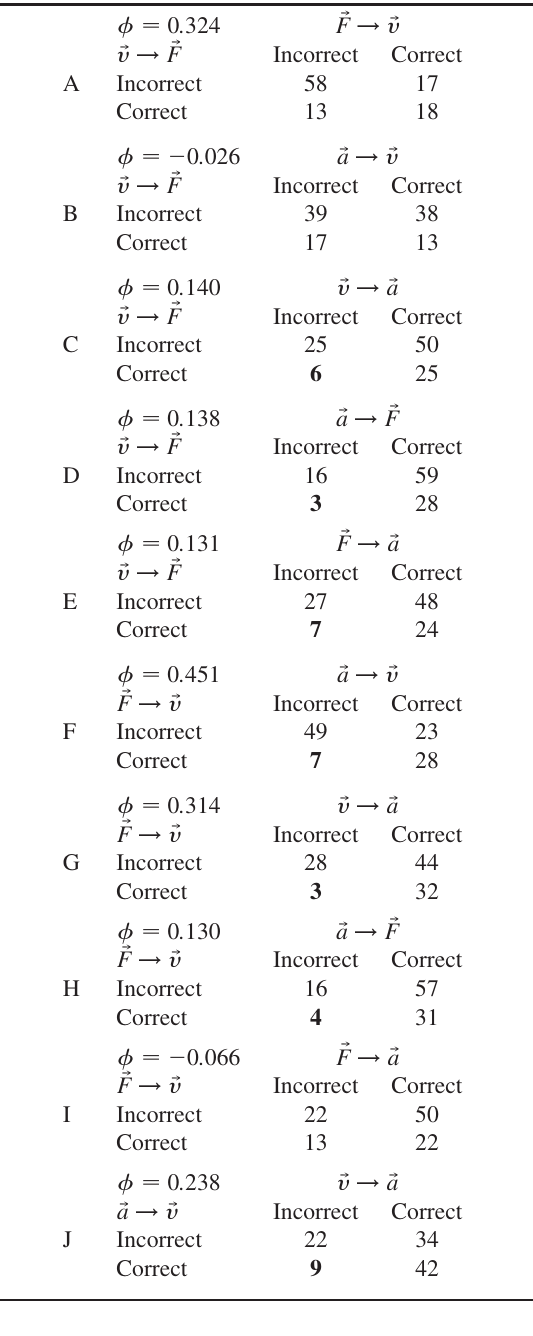
TABLE IX. Within-student cross tabulations of scores be- tween various question types. Cells represent numbers of stu- dents. Data reported are from the standard calculus mechanics course. A cell count is represented in bold face for tables